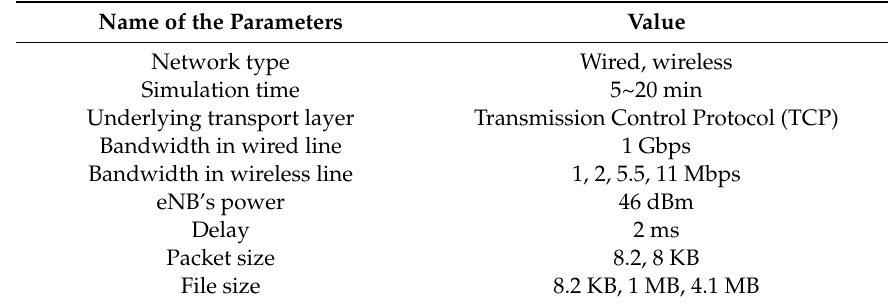
Table 2. Simulation